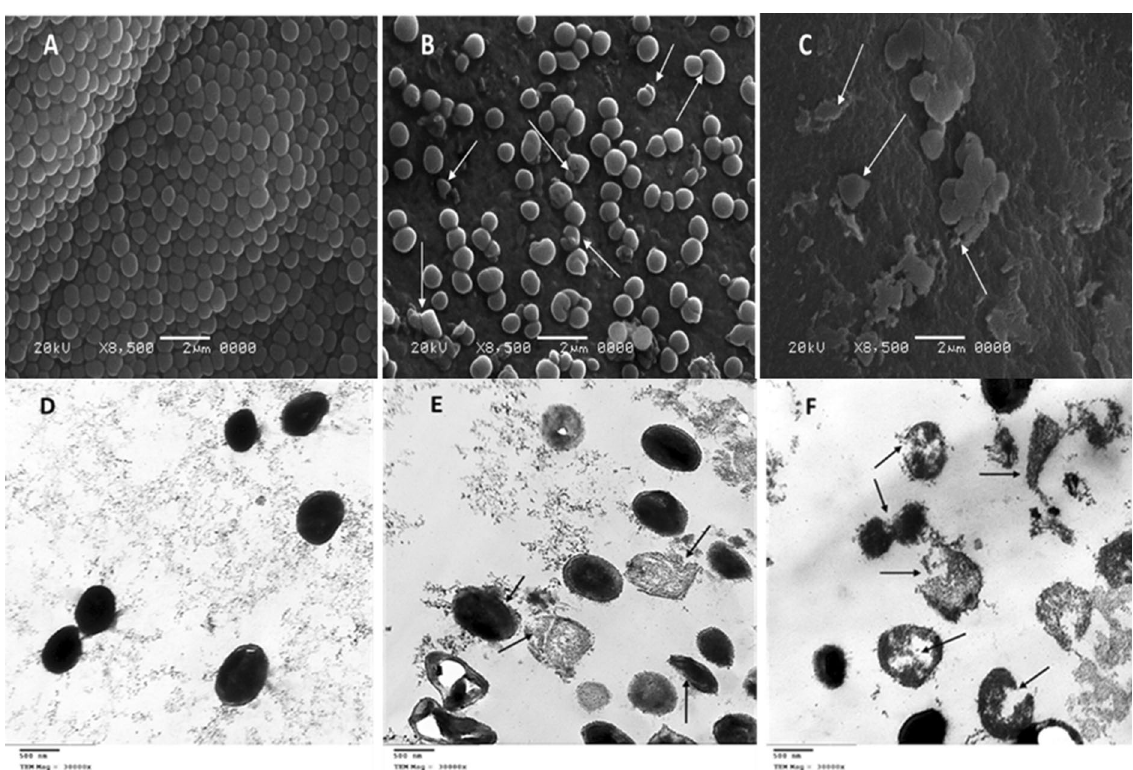
Figure 5. SEM micrographs of MRSA M-4 cells: ( A ) micrograph of untreated cells ( B ) treated cells with sublethal dose (half MIC) of penicillin-ZA-S combination ( C ) treated cells with a lethal dose (MIC) of the penicillin-ZA-S combination. TEM micrographs of MRSA M-4 cells: ( D ) micrograph of untreated cells ( E ) treated cells with half MIC of penicillin-ZA-S combination. ( F ) Treated cells with MIC of the penicillin-ZA-S